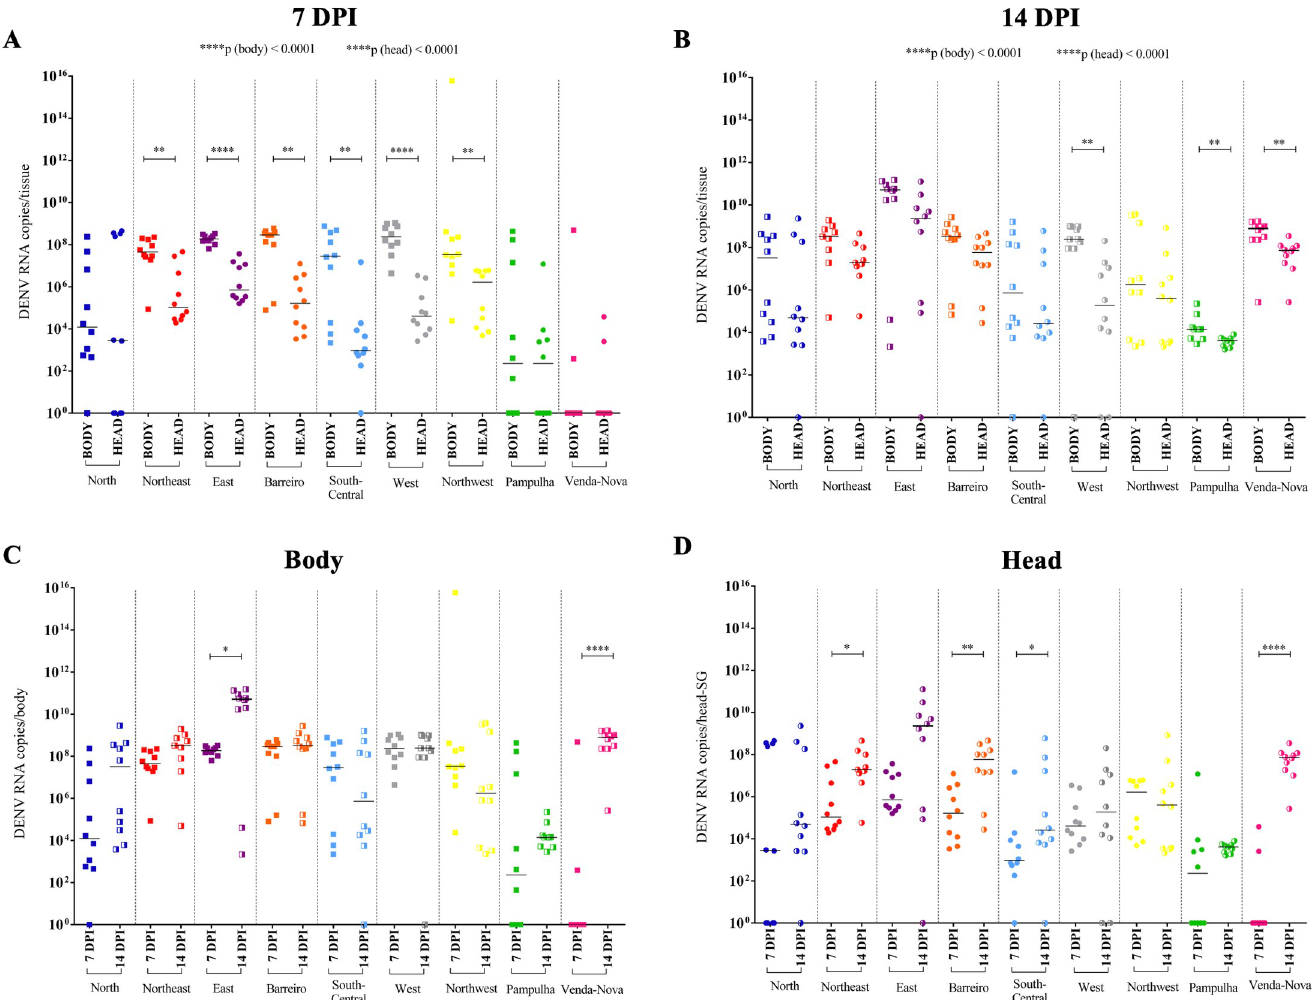
Fig 3. DENV viral load per body and head/salivary gland (SG) of Ae . aegypti at 7 and 14 days post-infection (dpi). A : DENV viral load per head/SG and body at 7 dpi in A . aegypti females from each district of Belo Horizonte. Each dot represents a tested female. B : DENV viral load per head/SG and body at 14 dpi in A . aegypti females from each district of Belo Horizonte. Each dot represents a tested female. C-D: Representation of the previous data (A-B) in another layout model to highlight the differences in DENV viral load between 7 and 14 dpi in the body ( C ) and head/SG ( D ) of the Ae . aegypti mosquitoes from each of the nine populations of Belo Horizonte. Fully filled and half-filled squares represent viral load in the mosquito bodies at 7 and 14 dpi, respectively. Fully filled and half-filled circles represent viral load in the mosquito head/SG at 7 and 14 dpi, respectively. P values > 0.05 (not significative) are not represented. P values � 0.05, � 0.01, � 0.001, � 0.0001 are summarized with one, two, three, and four asterisks,